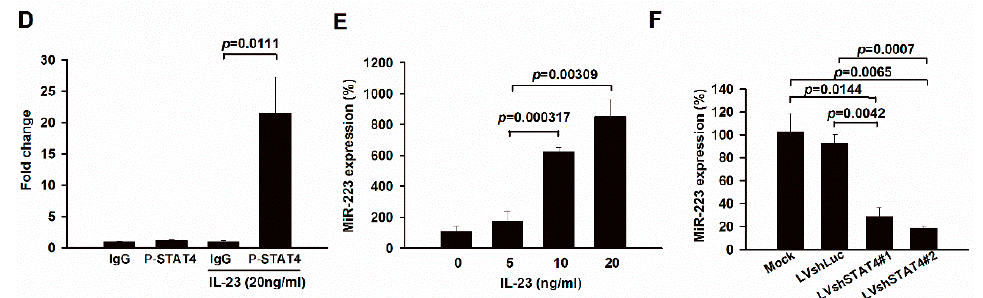
Figure 2. Association of IL-23 signaling with miR-223 in osteoclastogenesis. ( A ) Tartrate-resistant acid phosphatase (TRAP) staining and quantification in IL-23 (5 and 20 ng/mL) treated bone marrow-derived macrophages (BMMs). Each value shown represents the mean ± SEM ( n = 4). ( B ) TRAP staining and quantification in LVmiR-223T and LVshLuc-infected BMMs (MOI = 0.05 and 0.5) in response to IL-23 stimulation (20 ng/mL). Each value shown represents the mean ± SEM ( n = 3). ( C ) TRAP staining and quantification in LVshSTAT4#1 (TRCN0000081638), LVshSTAT4#2 (TRCN0000081639) and LVshLuc-infected BMMs (MOI = 1 and 5) in response to IL-23 stimulation (20 ng/mL). Scale bars represent 200 μ m in ×100 magnifications. Each value shown represents the mean ± SEM ( n = 3). ( D ) Binding of phosphorylated STAT4 to the miR-223 promoter in IL-23-treated RAW264.7 cells by determining with quantitative chromatin immunoprecipitation (qChIP) assay. Each value shown represents the mean ± SEM ( n = 3). ( E ) Expression of miR-223 in BMMs treated with various concentrations of IL-23 for 12 h, as determined by quantitative RT-PCR (qRT-PCR). Each value shown represents the mean ± SEM ( n = 3). ( F ) Expression of miR-223 in LVshLuc, LVshSTAT4#1 (TRCN0000081638) and LVshSTAT4#2 (TRCN0000081639)-transduced BMMs upon stimulating with IL-23 (20 ng/mL) for 12 h, as determined by qRT-PCR. Each value shown represents the mean ± SEM ( n = 3). Red boxed areas are shown at higher magnification in the panels beneath them . Results are representative of two independent experiments.